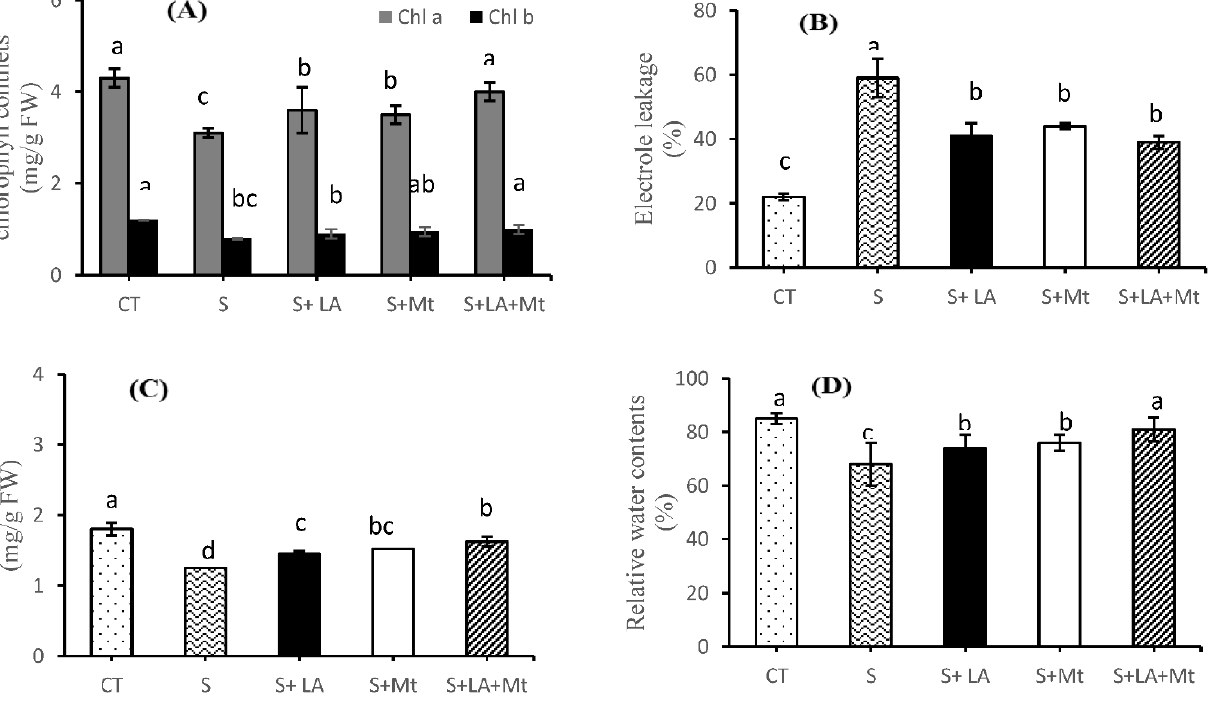
Figure 3. The effect of lipoic acid (LA), melatonin (MT), and their combination (LA + MT) under salt stress on chlorophyll contents ( A ), electrolyte leakage ( B ), carotenoid contents ( C ), relative water contents ( D ) of Brassica napus L. seedlings exposed to salinity (100 mM NaCl) for 30 days. Abbreviations are given in the Figure 1. Error bars on each column show the ± SE of three replication samples. Different letters on each bar indicate a significant difference according to the LSD test ( p ≤ 0.05).